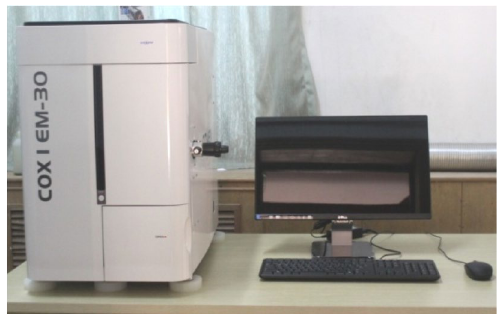
Figure 5. Scanning electron microscope.